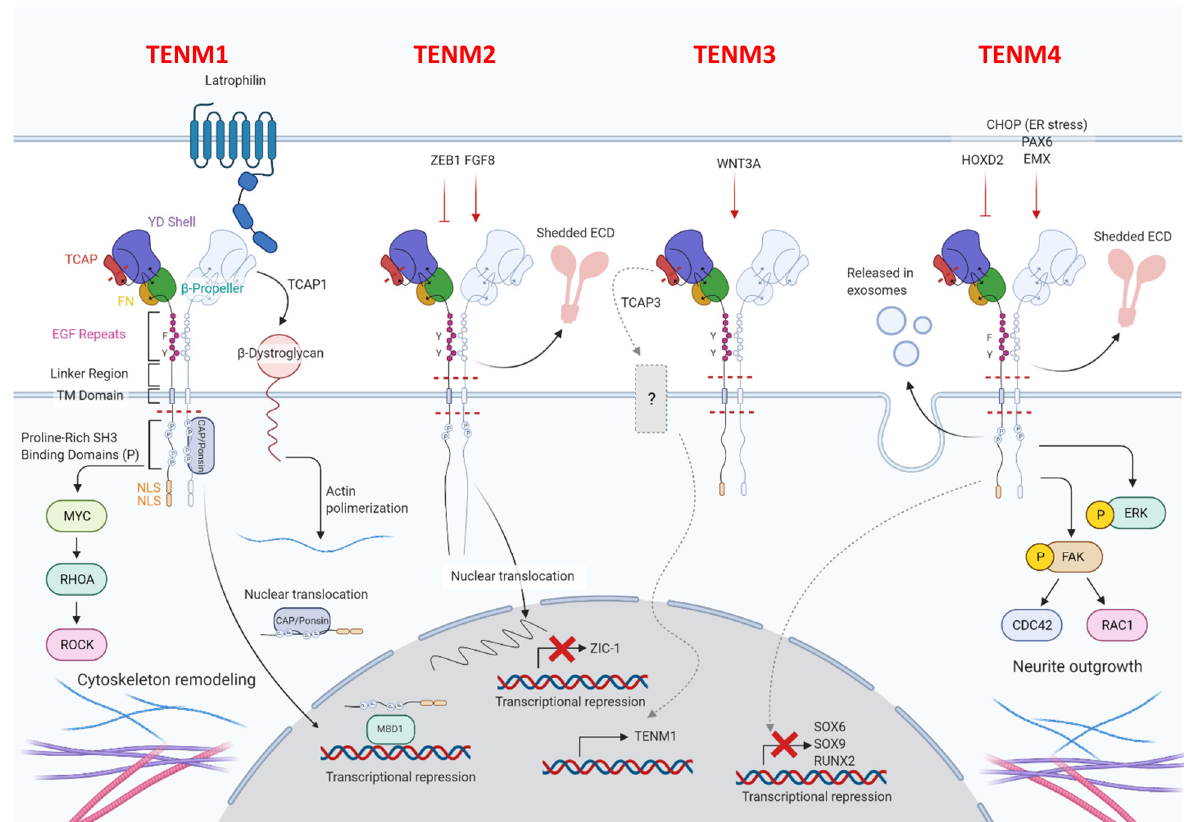
Figure 1. Schematic representation of teneurins’ structure and their molecular interactions. Teneurins display different major domains: the C-terminal extracellular domain, the transmembrane domain (TM domain) and the N-terminal intracellular domain. The C-terminal domain is composed of a globular part divided into a teneurin C-terminal associated peptide (TCAP), a tyrosine-aspartic acid (YD)-repeat barrel, a 6-bladed β -propeller domain, and a fibronectin plug (FN) domain. The globular portion of the protein is responsible for teneurins’ protein–protein interactions with, for example, latrophilins. The globular part of the protein is followed by eight epidermal growth factor (EGF) modules, that differ among teneurins. Indeed, while TENM1 and TENM4 have a phenylaniline (F) in the third residue of the fifth EGF repeat, TENM2 and TENM3 possess, instead, a tyrosine residue (Y). Teneurins cross the membrane via some hydrophobic residues that are linked to the N-terminal intracellular domain. Among the transmembrane domain and the EGF repeats, TENM2–4 have a cleavage site (represented by the red dashed lines) that allows the release of the extracellular domain (ECD). Finally, all teneurins possess a cleavage site in the intracellular domain allowing the intracellular portion to be processed and translocated to the nucleus and a cleavage that allows the release of TCAP. The N-terminal domain is characterized by one or more proline-rich SH3-binding domains, four in TENM1 and two in TENM2 and TENM4, and it terminates with predicted nuclear localization sequences (NLS), two in TENM1 and one in TENM3 and TENM4. This graphical representation also shows the functional interactions between teneurins and other proteins. The cytoskeleton remodeling operated through TENM1 action via a Myc-dependent transcriptional up-regulation of ras homolog family member A (RhoA) and consequent rho-associated protein kinase (ROCK) activation is shown. Moreover, TENM1 binds CAP/ponsin, which translocate in the nucleus. In the nucleus, the intracellular domain of TENM1 is able to bind MBD1, a DNA binding protein acting as transcription repressor. Moreover, TCAP1 can be released and bind β -distroglican inducing actin polymerization. TENM2 expression can be induced by fibroblast growth factor 8 (FGF8) and inhibited by Zinc finger E-box binding homeobox (ZEB1). Moreover, TENM2 nuclear translocation inhibits zic-1 expression. TENM3 expression is induced by Wnt3a, and TCAP3 release is able to impair TENM1 expression. TENM4 expression is induced by CAAT enhancer binding protein homologous protein (CHOP), upon endoplasmic reticulum stress, PAX6 and EMX, while it is inhibited by HOXD2. Moreover, TENM4 increases ERK phosphorylation as well as focal adhesion kinase (FAK), which causes the activation of CDC42 and RAC1, inducing neurite outgrowth. Differently, TENM4 higher expression decreases SOX6, SOX9 and RUNX2 expression. “Created with